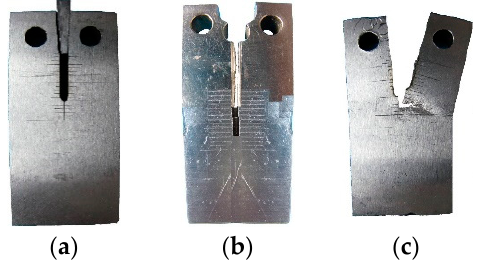
Figure 16. Cracked specimens over the cross-section of the WJ template with a roof and different configurations ( a , b ), which, during crack propagation, can serve as traps for cracks and change their trajectory. Example of uncontrolled deviation of the crack propagation direction at the angle up to 90° ( c ).